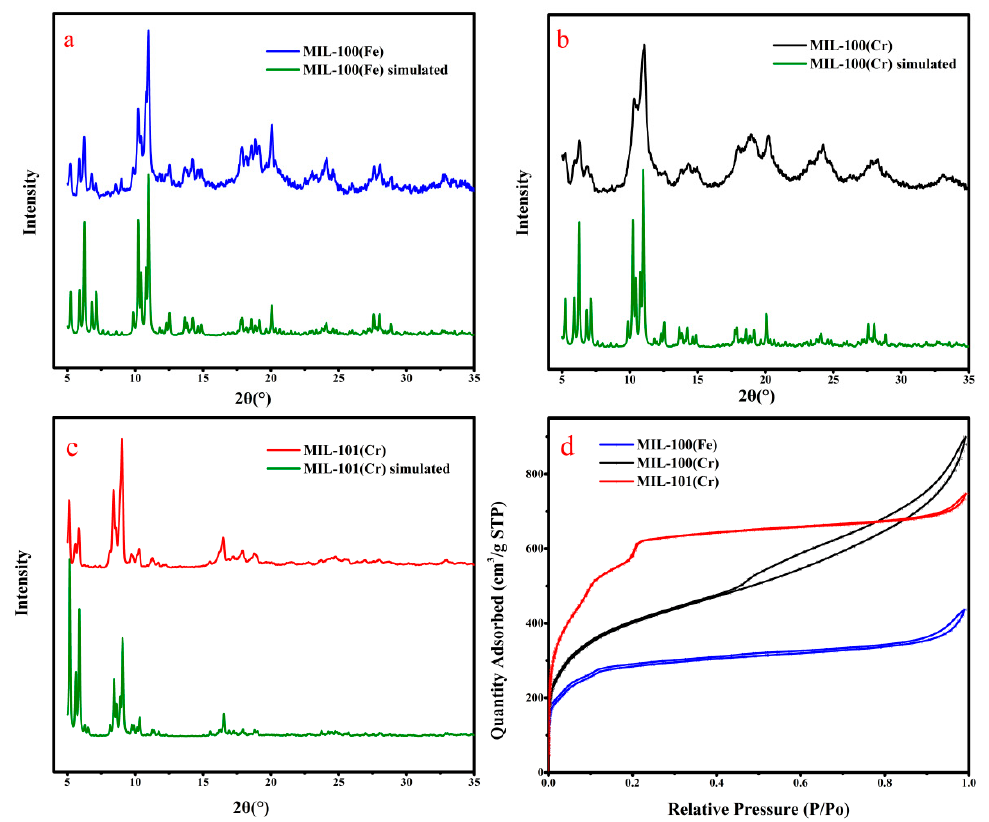
Figure 3. ( a ) XRD patterns of MIL-100(Fe); ( b ) XRD patterns of MIL-100(Cr); ( c ) XRD patterns of MIL-101(Cr); ( d ) N 2 adsorption-desorption isotherms (at 87 K) of MIL-100(Fe) (blue), MIL-100(Cr) (black) and MIL-101(Cr) (red).